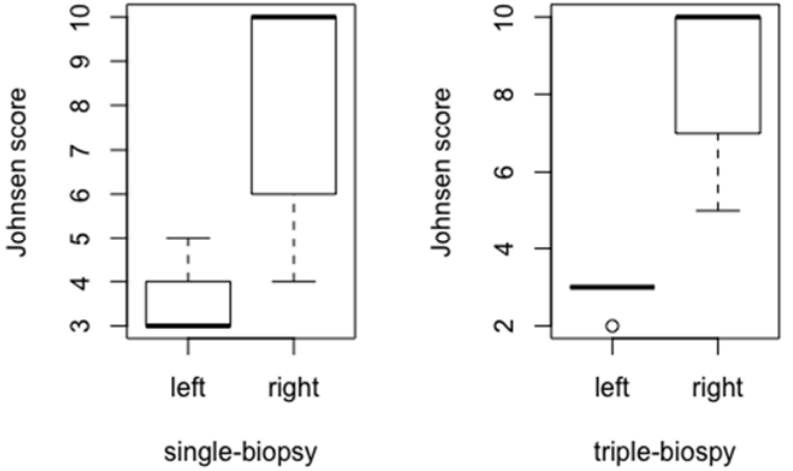
Figure 10. Comparison of atrophic tubules between the left and right testicles in single and triple- biopsy groups (Mann–Whitney U test, p < 0.001). The value of Johnsen score was significantly lower in the left (biopted) testicles ( p < 0.001) groups (Figure 11).